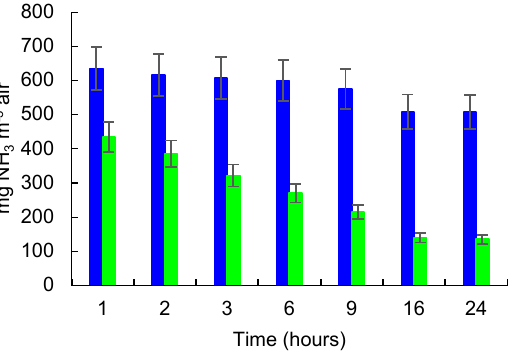
Figure 6. NH 3 released / adsorbed from 1 mL NH 4 OH solution 25%. NH 3 concentration (mg m − 3 ) in control box (blue color) and in box with zeolite (green color); error bars for 10% Ue rel are shown.